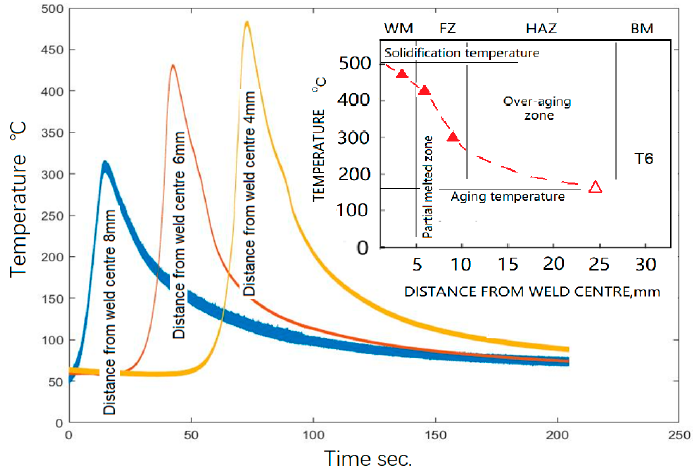
Table 4. Chemical compositions of filler wire and WM of joint (wt.%).